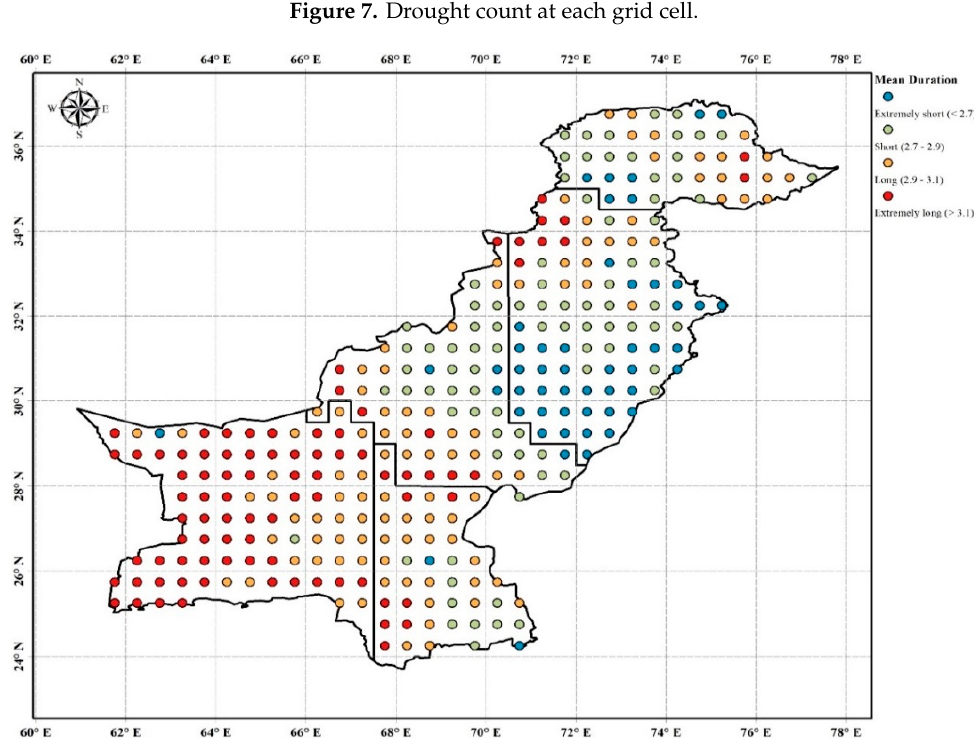
Figure 8. Mean duration of droughts that occurred from 1902–2015 at each grid cell.